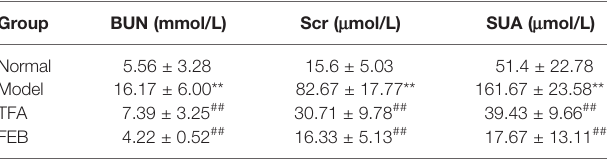
Thedataareexpressedasthemean±SD.**P<0.01vs.theNormalgroup. ## P<0.01vs. the Model group. BUN,bloodureanitrogen;Scr,serumcreatinine;SUA,serumuricacid;TFA,total fl avones of Abelmoschus manihot; FEB, febuxostat; SD, standard